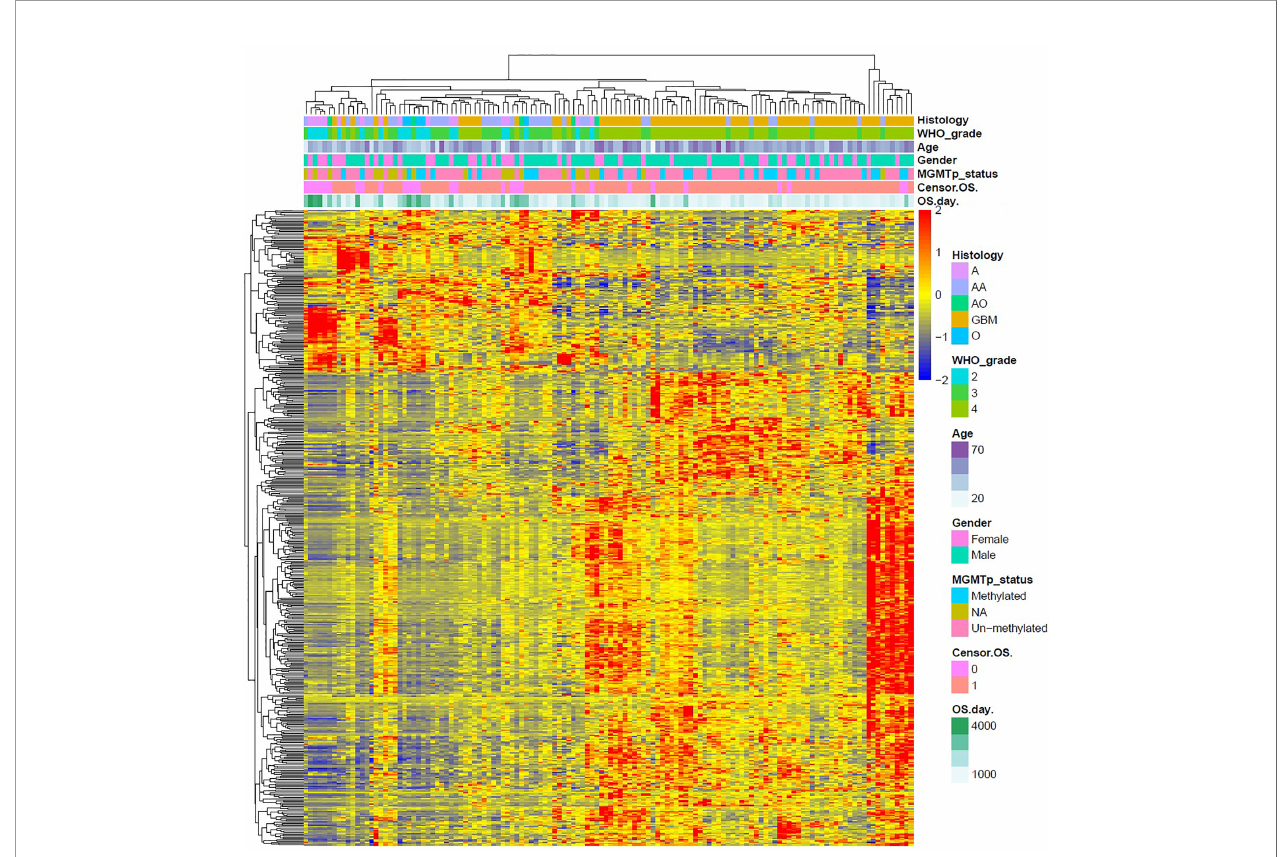
FIGURE 2 | Supervised cluster analysis of the gene sequencing data. We obtained gene heat maps describing gene expression in the different patient groups and found that there were obvious differences in gene expression levels and gene expression types between IDH-wt LGG patients and IDH-wt GBM